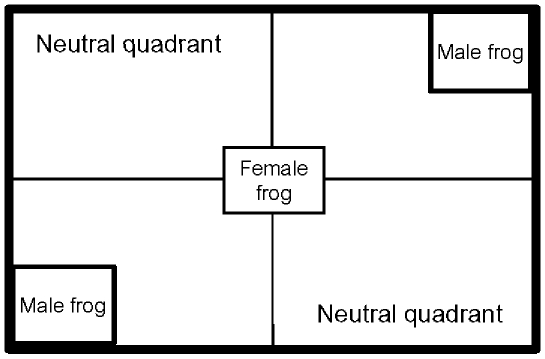
Diagrammatic representation of the arena used in mate choice trials.